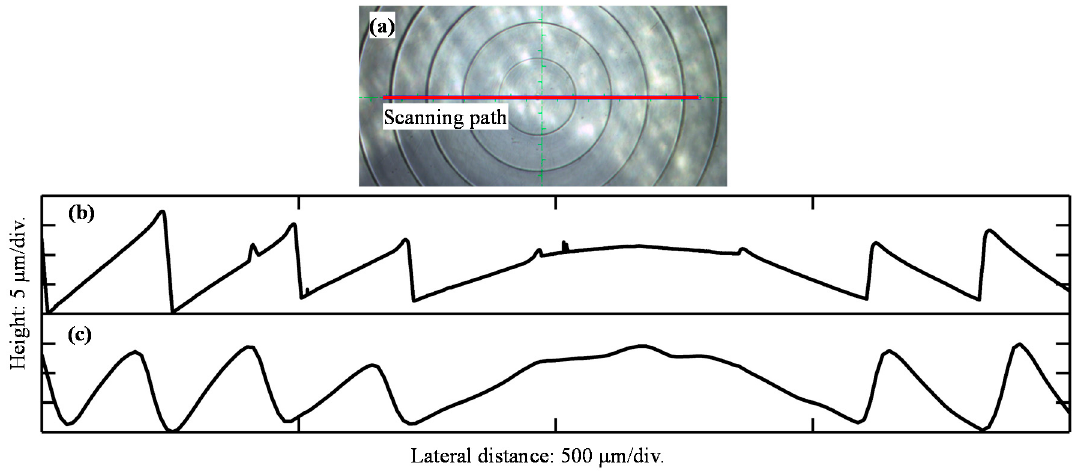
Figure 8. Fresnel lens section profile. ( a ) Scanning path; ( b ) P-7 test result; ( c ) CCT test result.